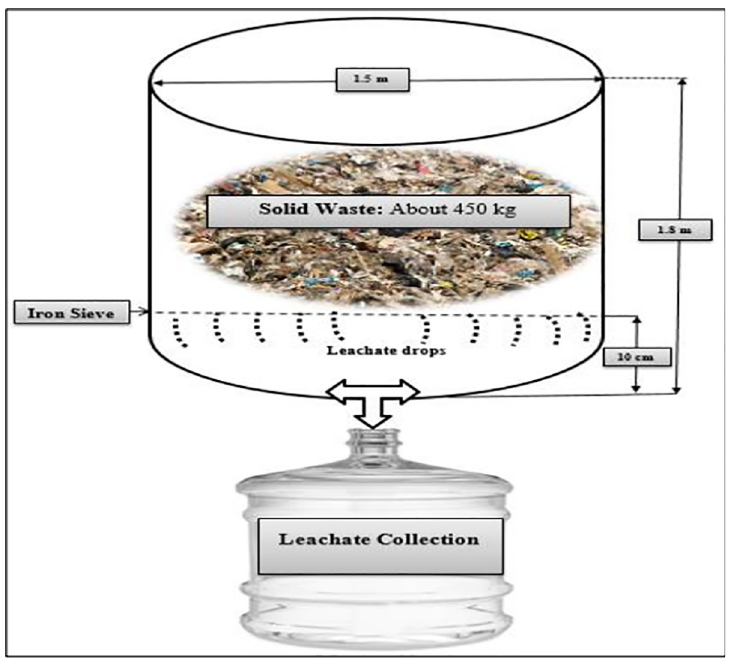
Fig 1. Schematic of leachate production setup.